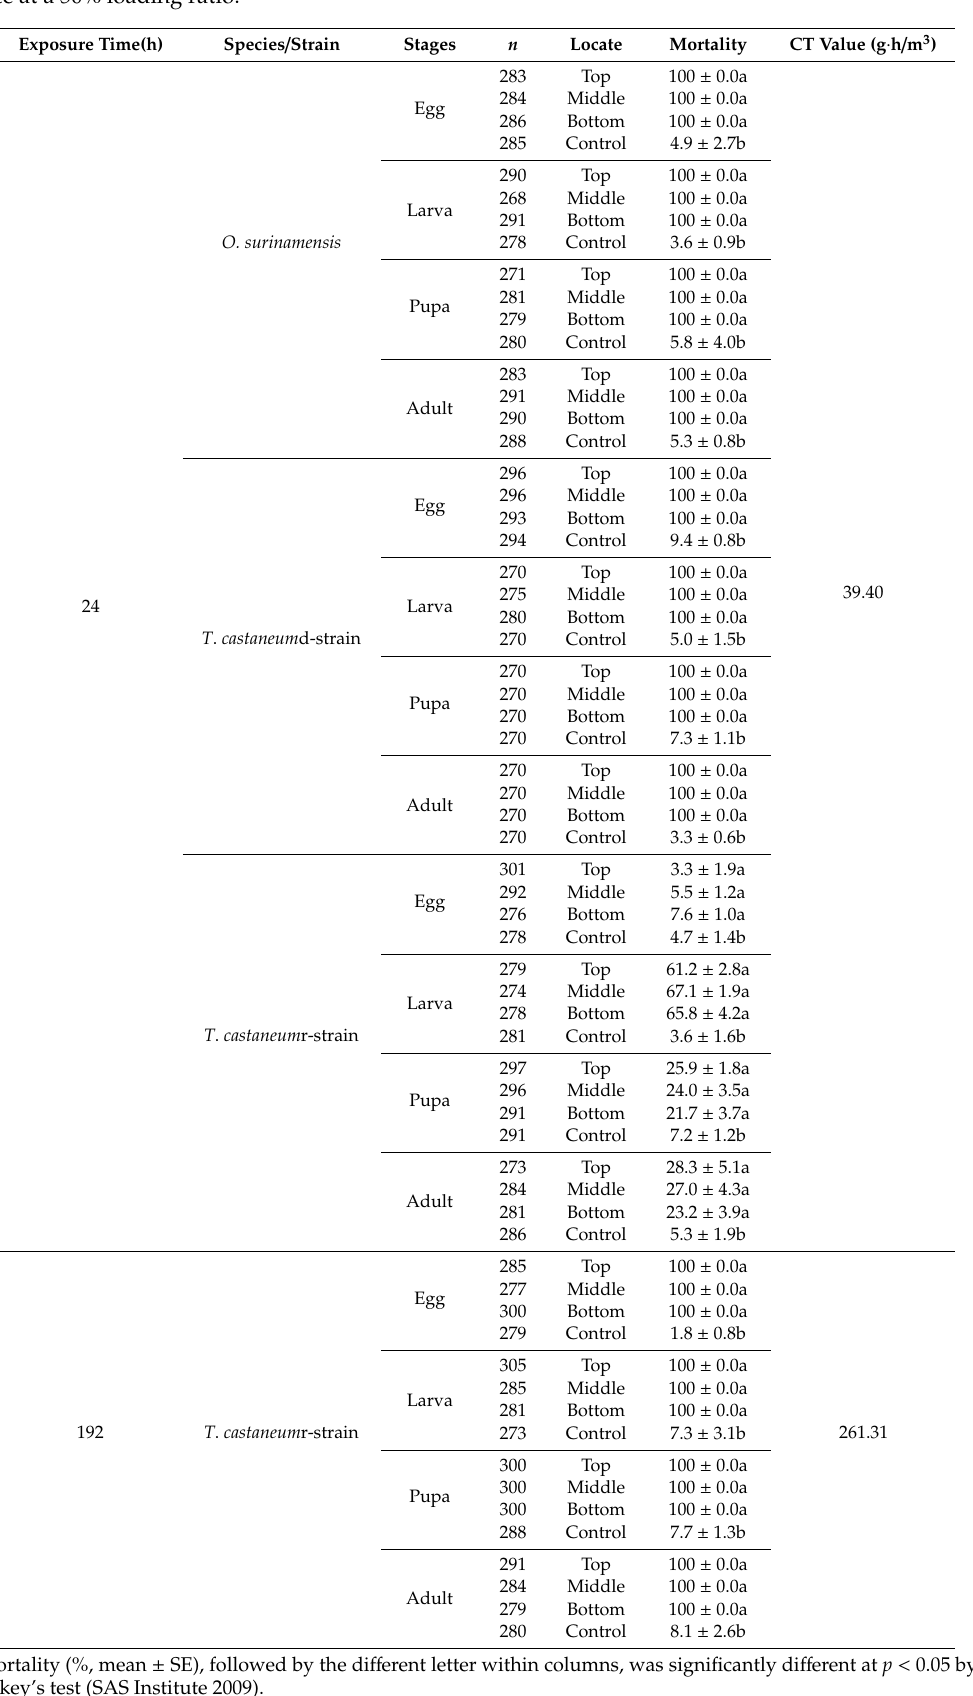
Table 1. Fumigant activity of 2 g / m 3 PH 3 at each location in a 0.5 m 3 fumigation chamber containing rice at a 50% loading